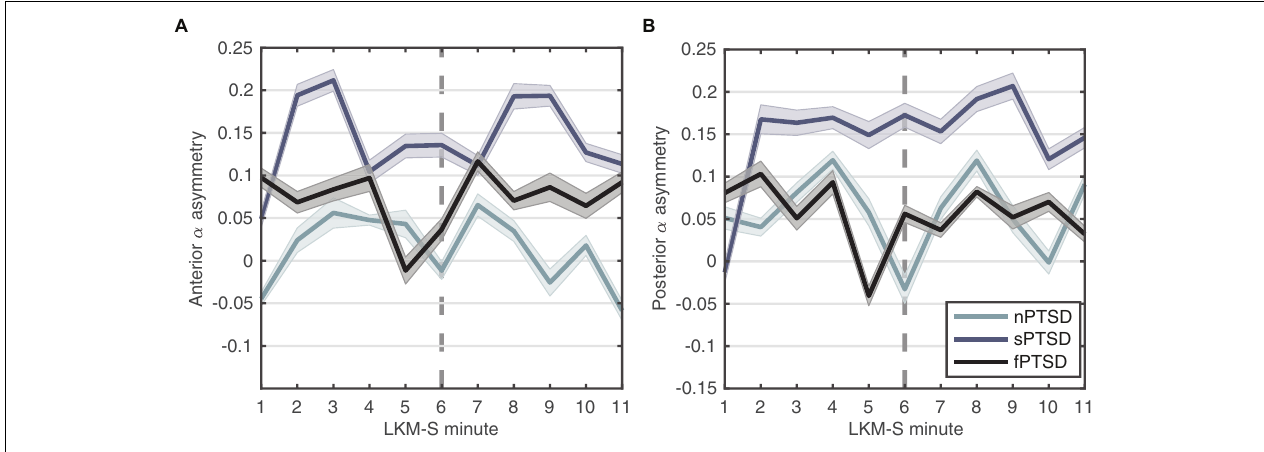
FIGURE 6 | Alpha-asymmetry (R-L) computed for (A) anterior and (B) posterior during each minute of the LKM-S for each group. Error bars are ± 1 SE. In minutes 1–5 participants focus on others, minutes 6–11 participants focus on the self.